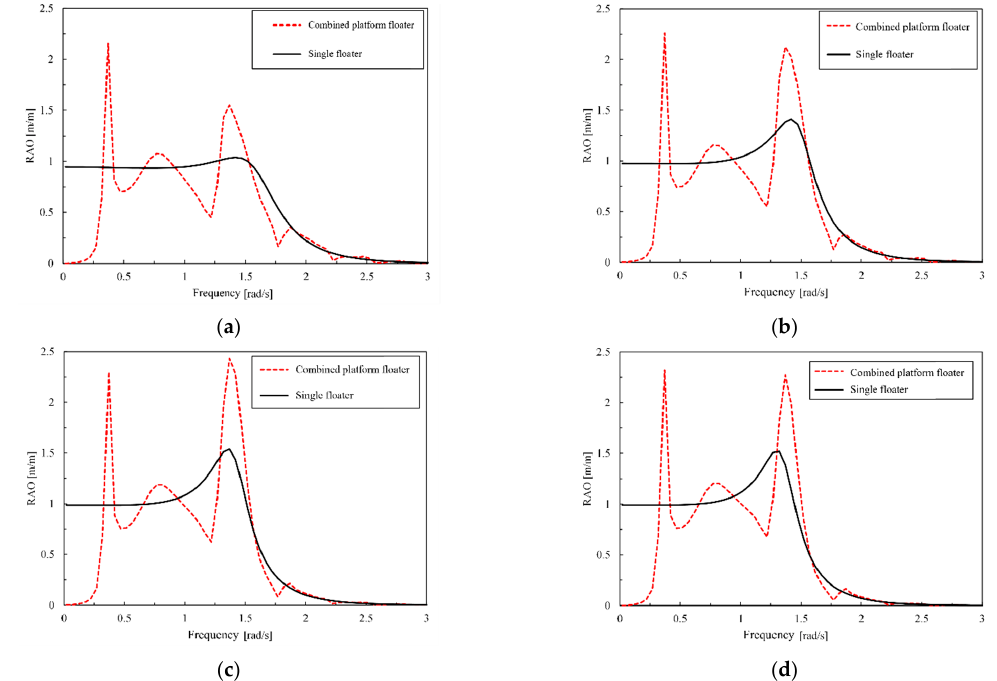
Figure 6. Comparison of RAO under different floater radii: ( a ) R = 2 m; ( b ) R = 3 m; ( c ) R = 4 m; ( d ) R = 5 m.